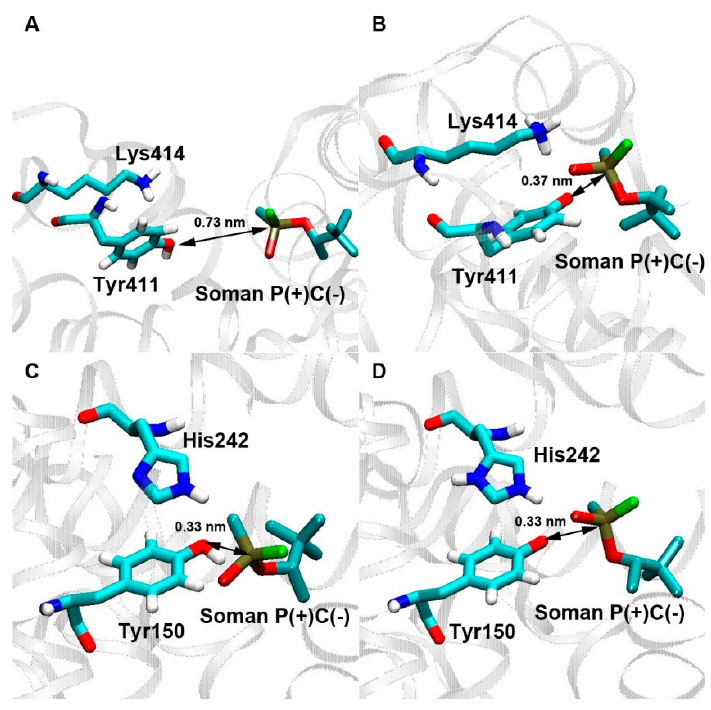
Figure 1. The results of molecular docking of P(+)C( − )-stereoisomer of soman into the sites of albumin Tyr411 ( A ,B) and Tyr150 ( C , D ) in the protonated ( A , C ) and deprotonated state of the tyrosine ( B , D ). In the hypothetically productive complexes ( B – D ), the distance between the phosphorus atom of soman and the hydroxyl oxygen of Tyr411 (150) is small enough (<0.4 nm) for the nucleophilic attack of the oxygen [66–68]; in addition, fluorine (colored green) and phosphorus atoms of soman and hydroxyl oxygen of Tyr411(150) are positioned in one line as it happens in cholinesterases [70].